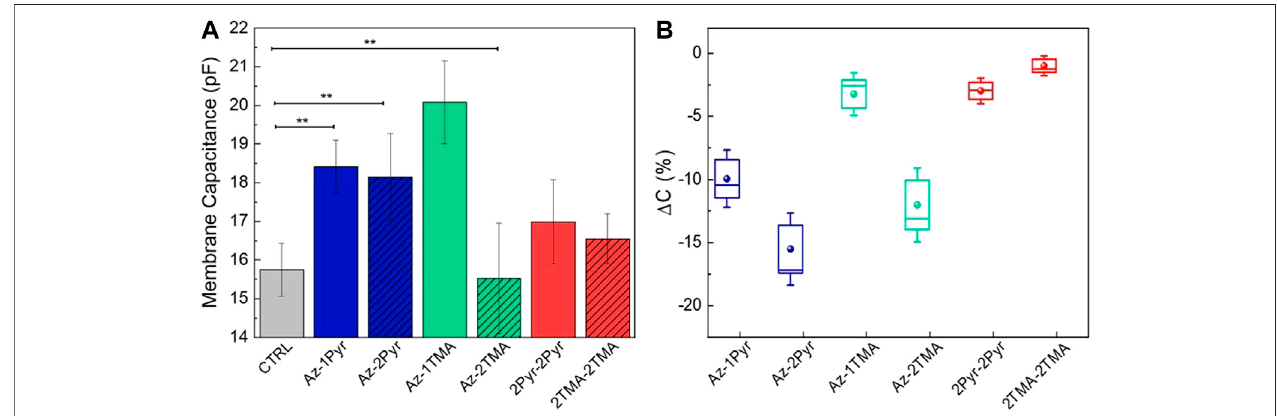
FIGURE4| Cellmembranecapacitancedata. (A) DependencyfromthesolelyazobenzenemoleculesinternalizationintoHEK-293cells,anddataarepresentedas mean ± standard error of the mean ( n ≥ 10). (B) Change in capacitance upon samples irradiation ( n ≥ 10). Data are normalized to the amount of molecules partitioned in the cell